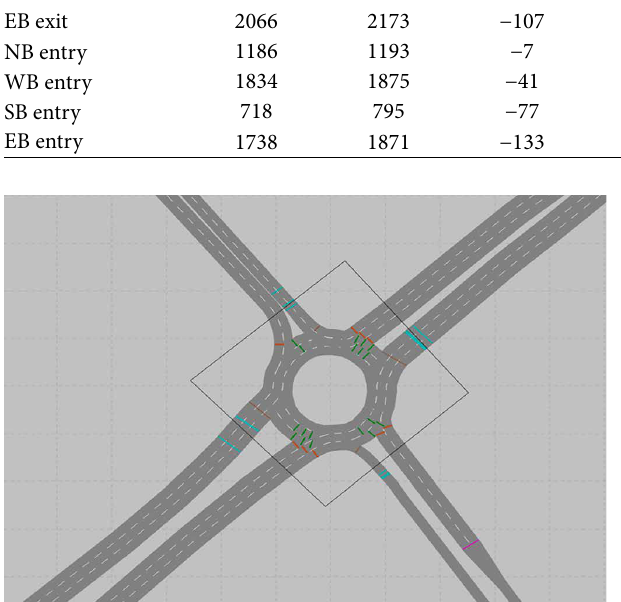
Figure 3: VISSIM layout of the three-lane conventional roundabout.